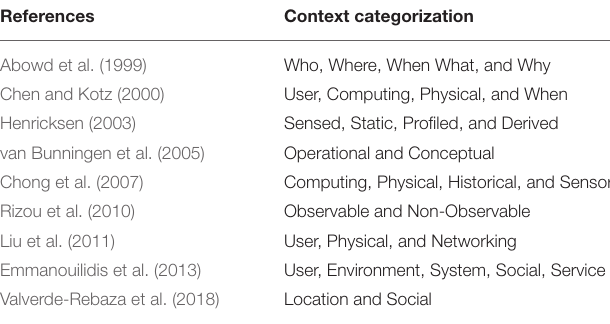
TABLE 1 | Different context categorization